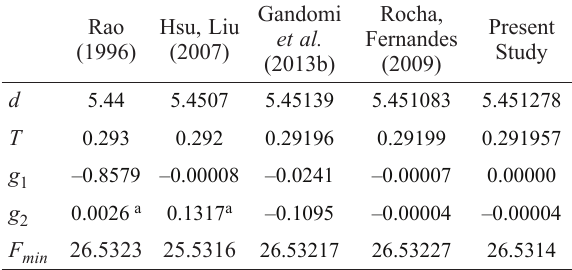
Table 2. Best solutions for the tubular column example Gandomi Rao Hsu, Liu et al. (1996) (2007)